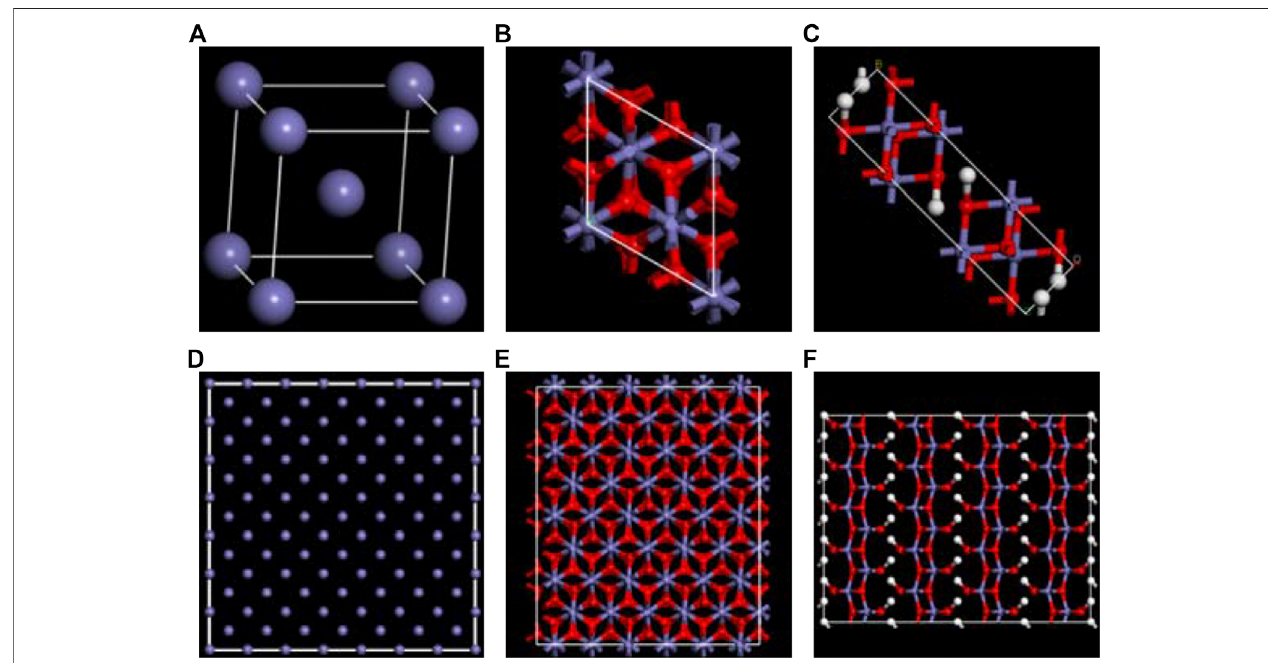
FIGURE1| Thecon fi gurationoforiginalunitof (A) Fe, (B) γ -Fe 2 O 3 , (C) γ -FeOOH.Andthesupercellstructuresof (D) Fe, (E) γ -Fe 2 O 3 ,and( F ) γ -FeOOH.Thepurple, red and white balls represent iron, oxygen, and hydrogen atoms, respectively.